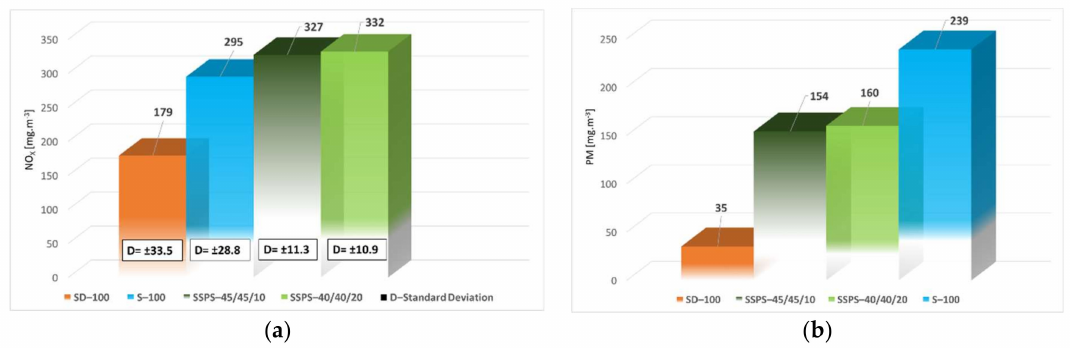
Figure 7. ( a ) Comparison of average NO X emissions, and ( b ) comparison of average particulate matters